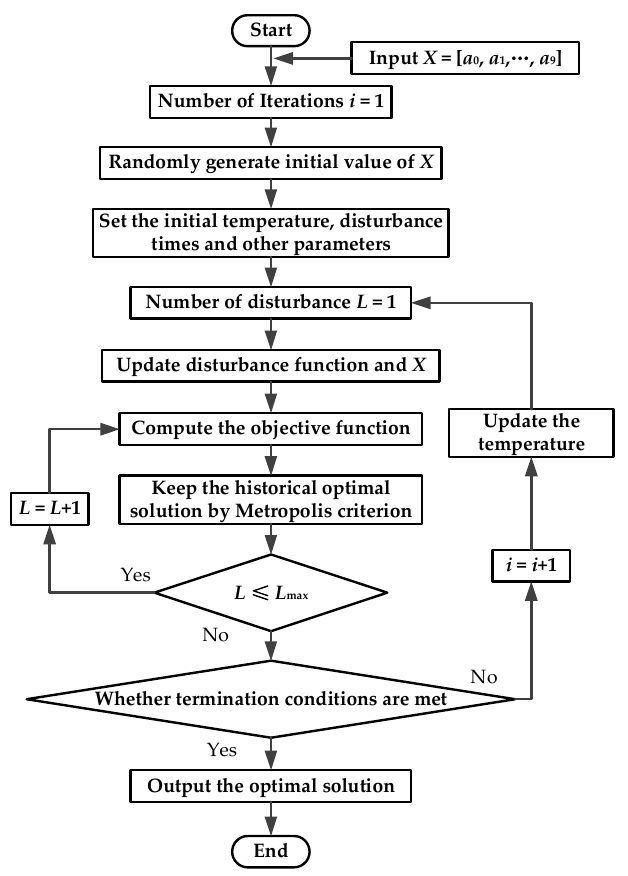
Figure 7. Flow diagram of the I-SA algorithm. Note: L is number of disturbances; X is the set of decision variables; i is number of Iterations; L max is maximum number of disturbances.